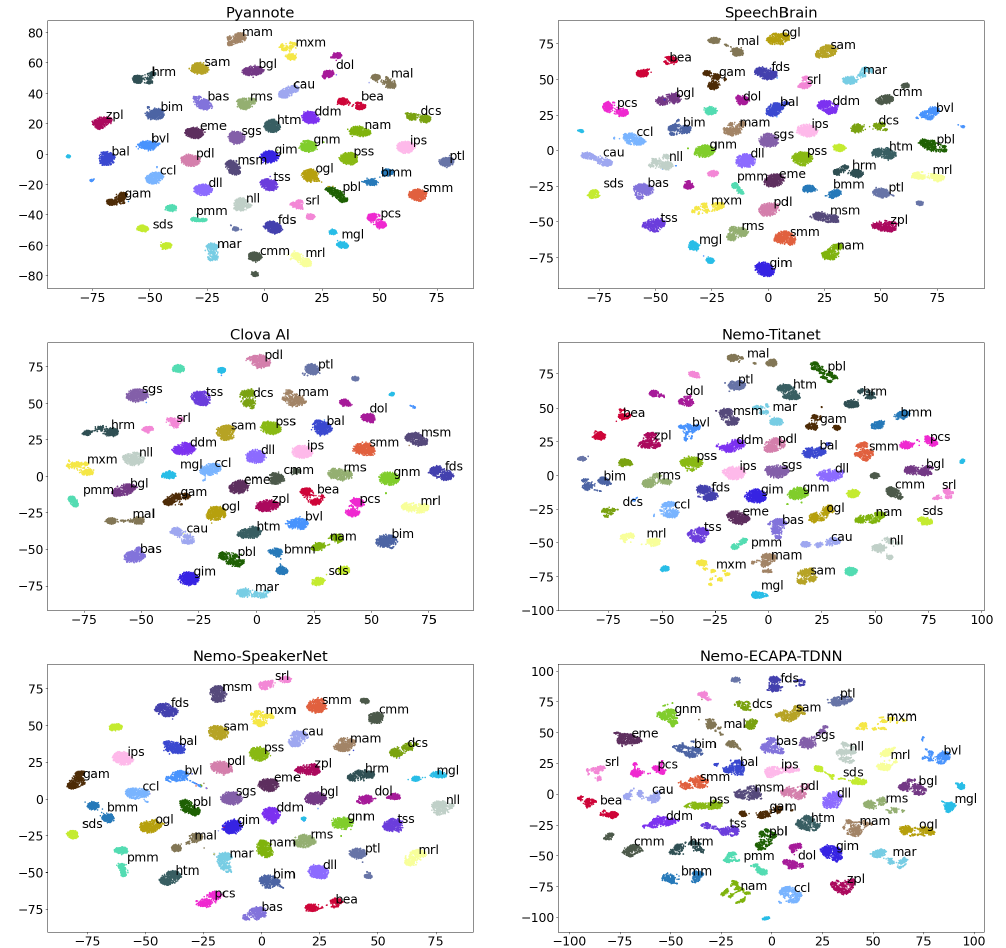
Figure 4. t-SNE representations of the speaker embeddings extracted from the different